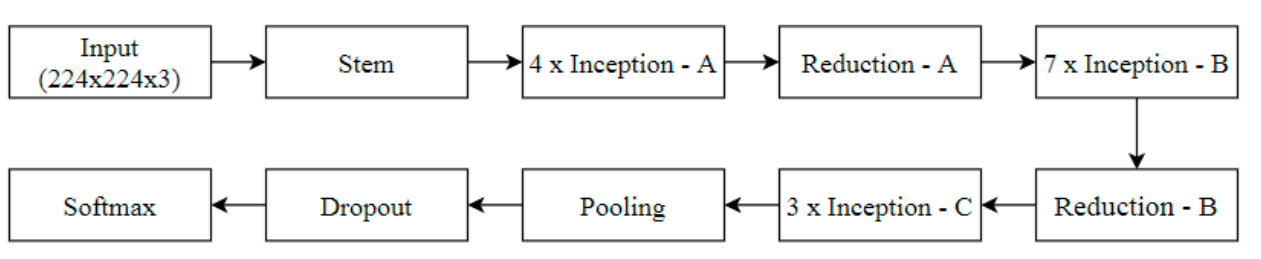
Figure 2. The Architecture of InceptionV4 is used for feature